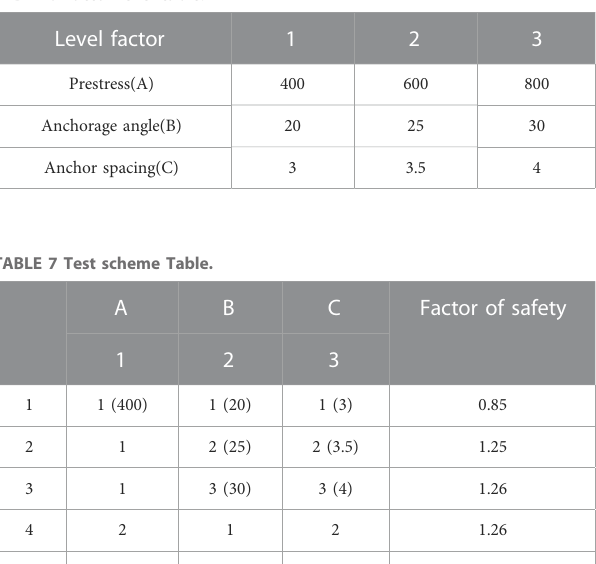
TABLE 6 Factor level table.